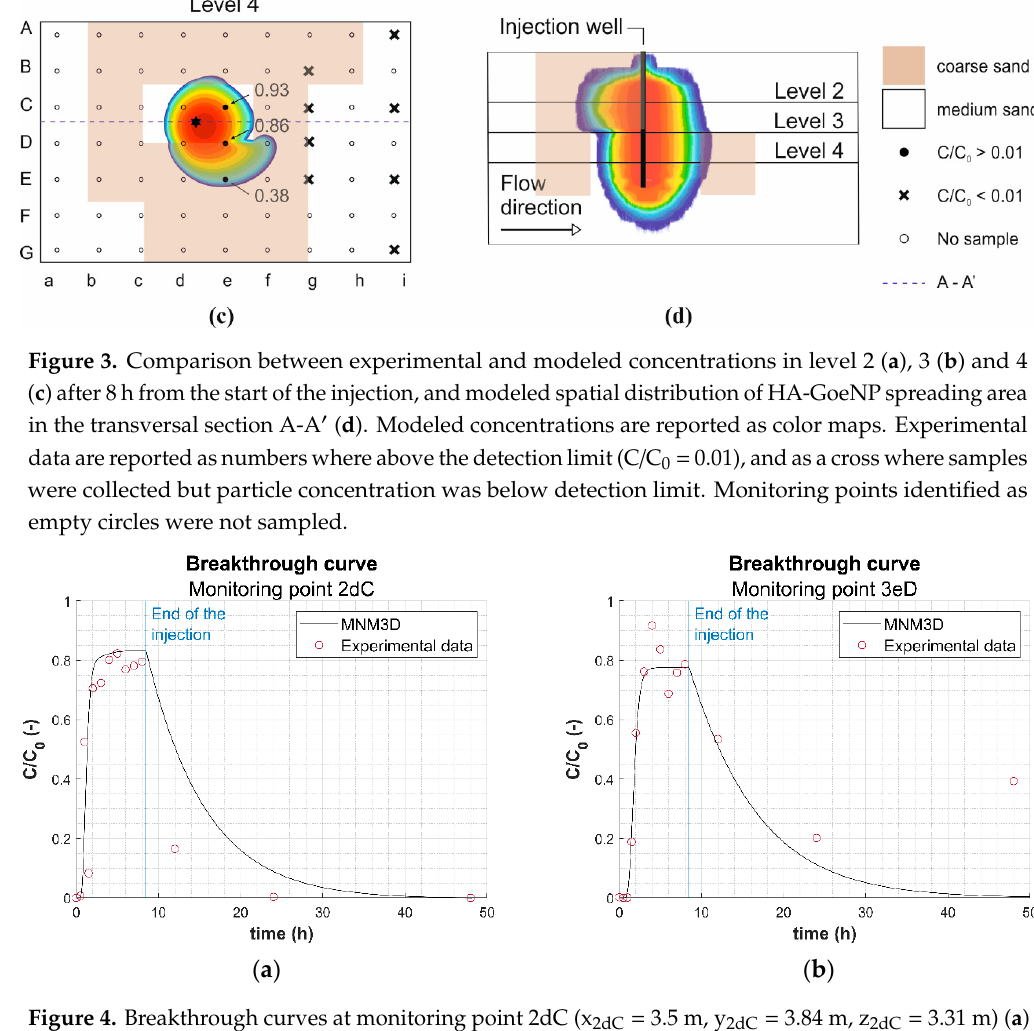
Figure 4. Breakthrough curves at monitoring point 2dC (x 2dC = 3.5 m, y 2dC = 3.84 m, z 2dC = 3.31 m) ( a ) and 3eD (x 3eD = 4.5 m, y 3eD = 2.9 m, z 3eD = 2.62 m) ( b ).